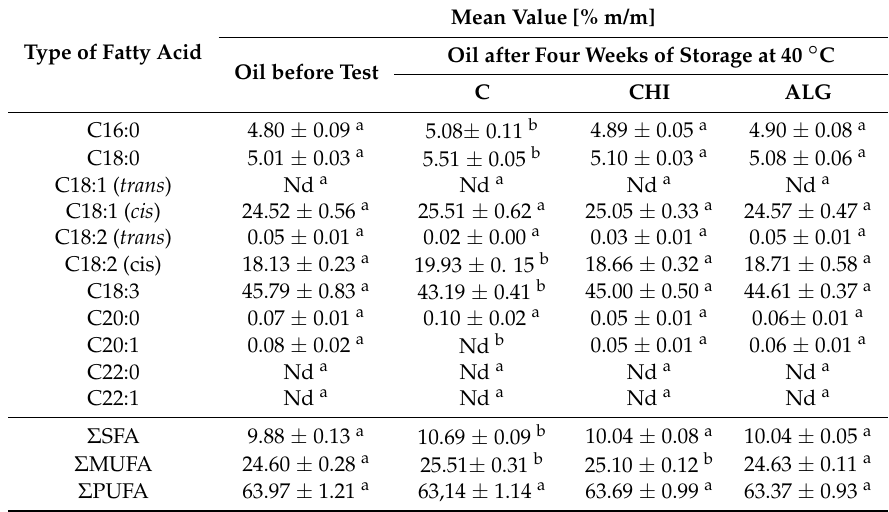
Table 6. Comparison of the composition of the most important fatty acids of linseed oil during four weeks of storage in non-encapsulated form and in the form of chitosan and alginate capsules. Mean Value [% m/m] Type of Fatty Acid Oil after Four Weeks of Storage at 40 ◦ Oil before Test